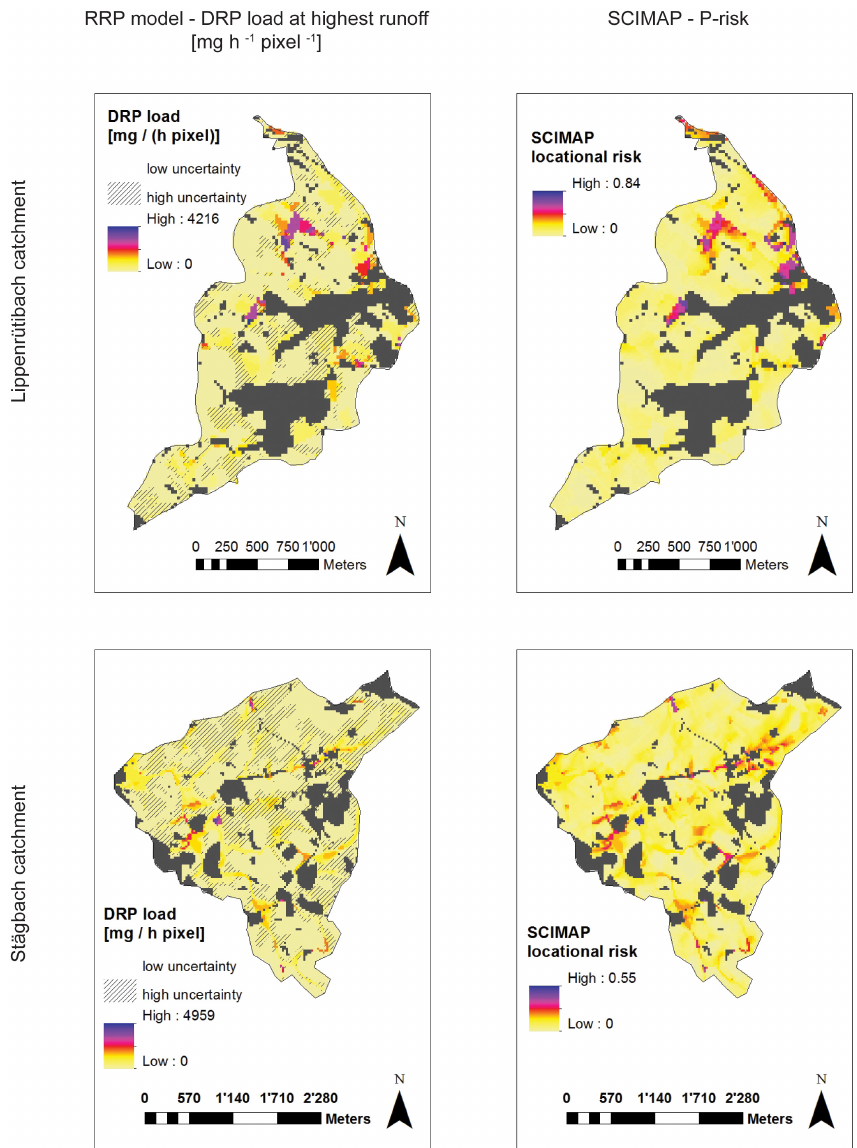
Figure 6. Spatial model results for P losses as predicted with the RRP model and the SCIMAP model, grey areas are forested or urban areas. Areas for which less than 80% of the RRP simulations resulted in the same distribution of fast-flow generation are